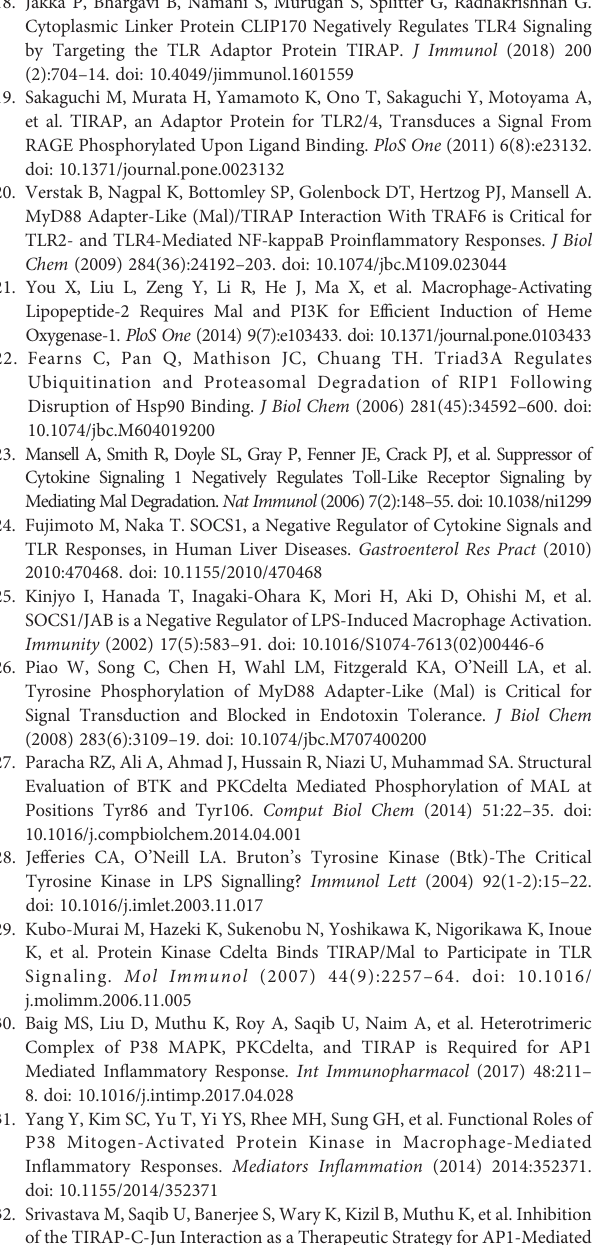
Supplementary Figure 1 | Representation of TIRAP TIR (Toll/Interleukin-1 Receptor) domain and computational prediction of serine (S), threonine (T) and tyrosine (Y) phosphorylation and cysteine (C) S-nitrosylation (SNO) positions. The TIRAP protein containing an N-terminal PBD and C-terminal TIR domain are highlighted. The predicted phosphorylation sites on top and SNO sites at bottom of domain map are indicated in blue and light brown colors, respectively. The experimentally proved phosphorylation sites (Y86, Y106, Y159, and Y187) are marked with asterisk. The predicted phosphorylation sites were obtained from kinase-based computational tools GPS-Phosphorylation (http://gps.biocuckoo.cn/) and NetPhos 3.1 (http://www.cbs.dtu.dk/services/NetPhos/). For cysteine (C) SNO sites, computational tools GPS-SNO (http://sno.biocuckoo.org/index.php), DeepNitro (www.deepnitro.renlab.org), and SNOSite (http://csb.cse.yzu.edu.tw/ SNOSite/predict.php) were